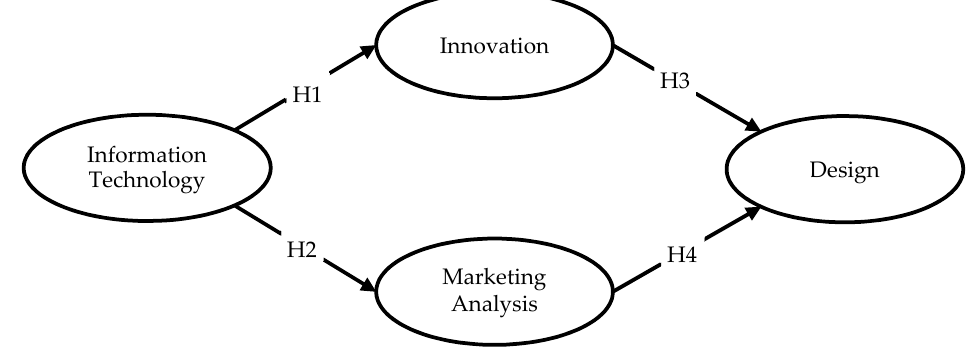
Figure 1. Framework of the study.